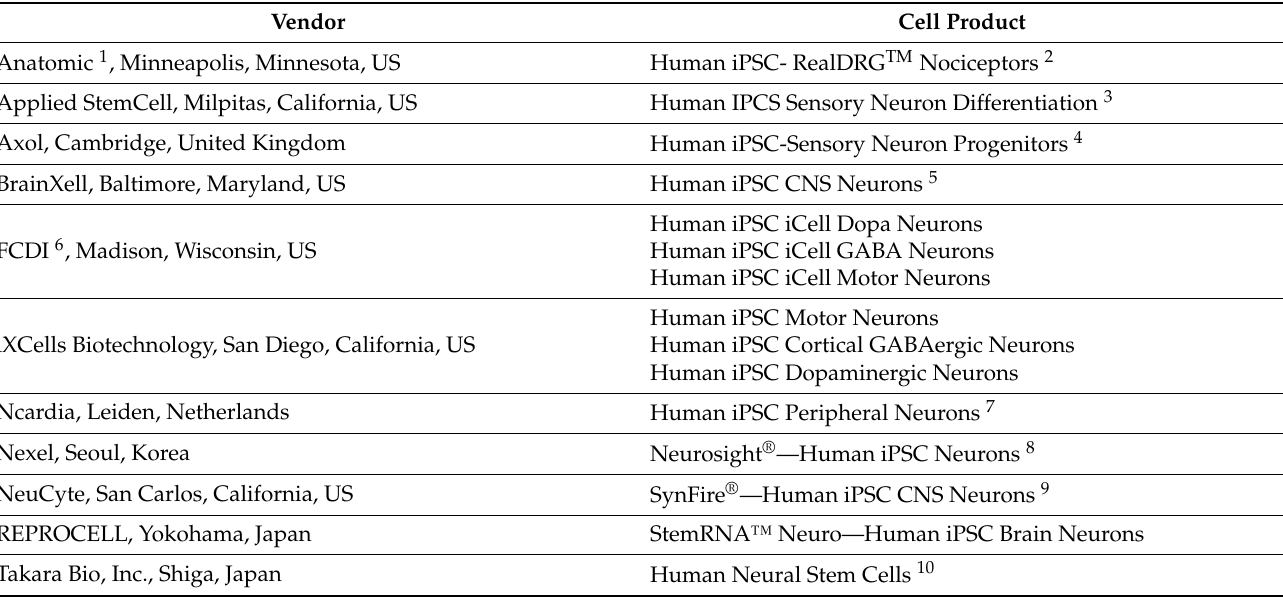
Table 2. List of vendors offering hiPSC-derived cells for neurotoxicity